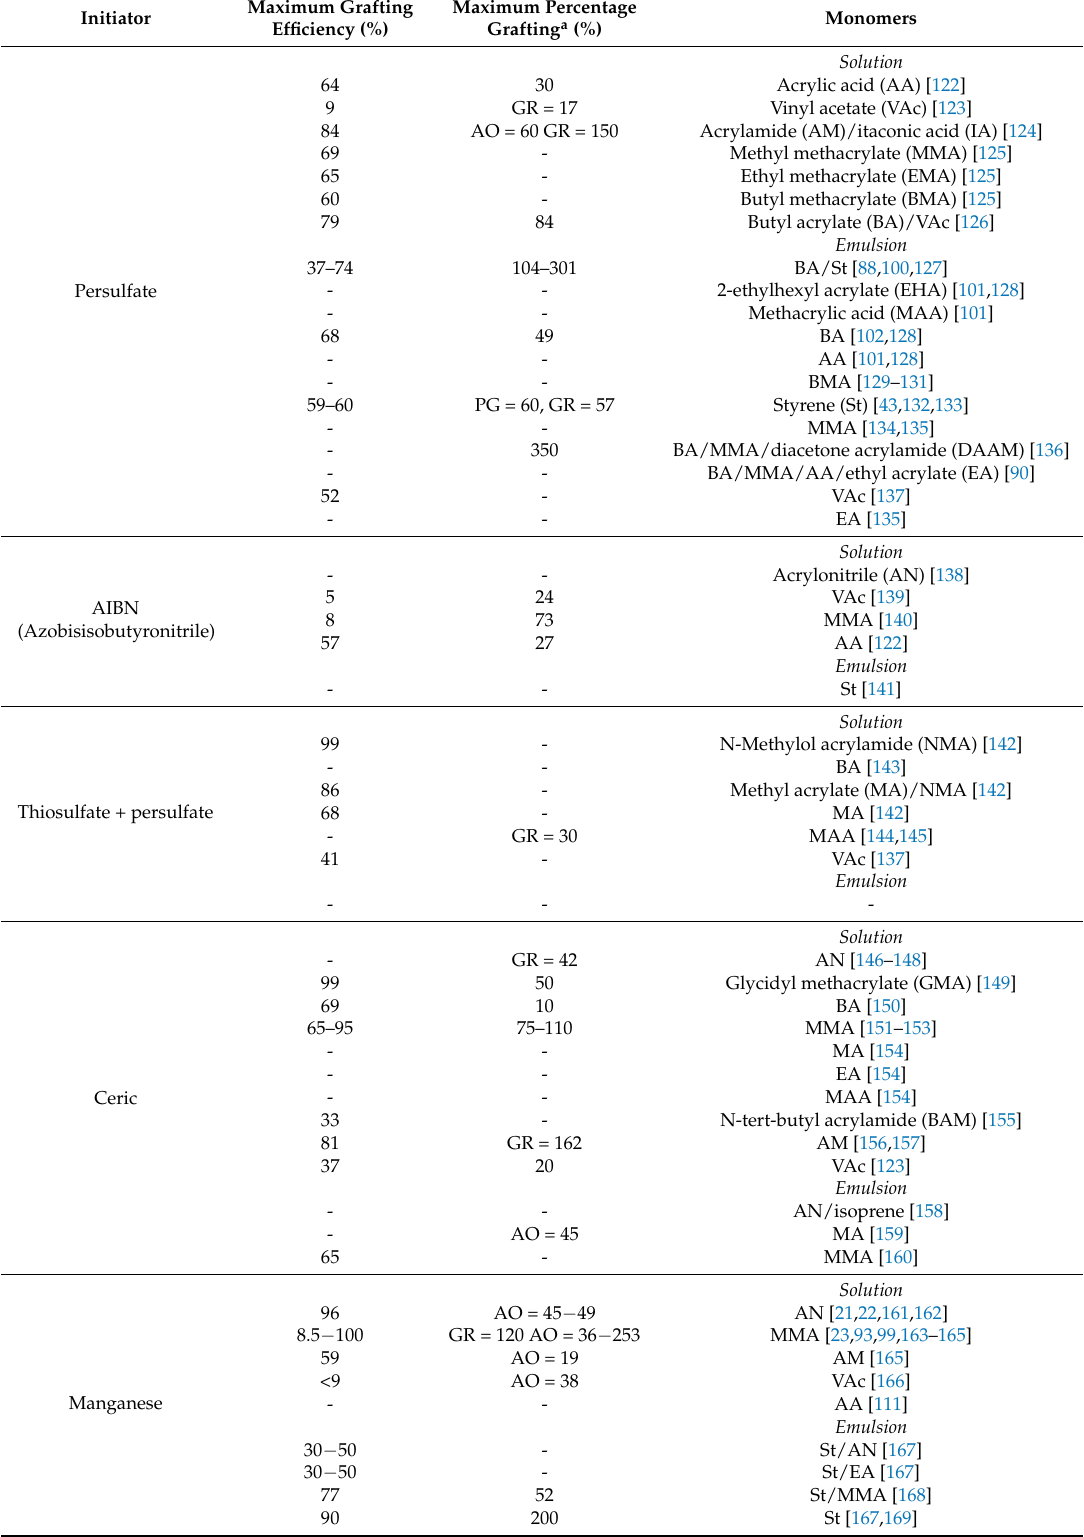
Table 6. Summary of grafting results for different initiation methods in starch graft